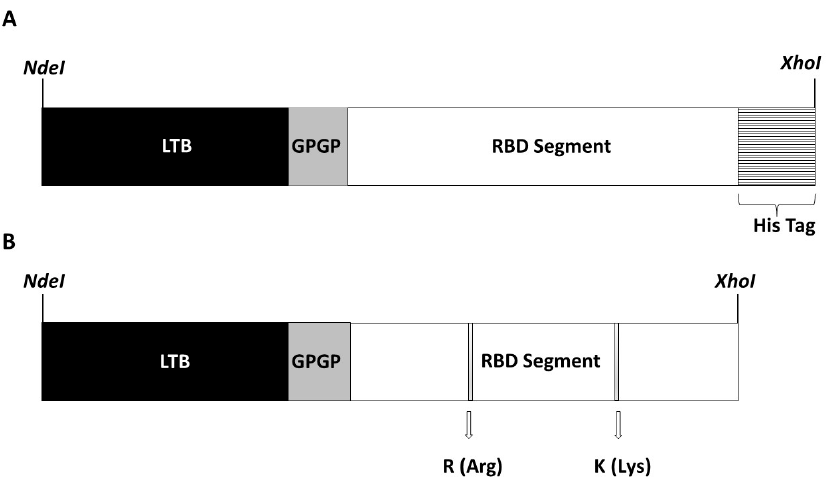
Figure 1. Schematic representation of the chimeric proteins produced and evaluated in this study. ( A ) Map of the chimeric protein LTB-RBD targeting the Wuhan isolate. ( B ) Map of the chimeric protein LTB-RBD targeting the delta variant. The fusion proteins comprise the full-length sequence of LTB (in black), a GPGP linker (in gray), a segment of the RBD from SARS-CoV-2 (aa 439 – 504, carrying B and T cell epitopes, in white), and hexa-histidine tag (in horizontal stripes). The delta variant construct has two amino acid changes (arrows): arginine (R) instead of leucine (L) and lysine (K) instead threonine (T). Nde I and Xho I restriction sites were placed at the 5 ′ and 3 ′ ends, respec- tively, to facilitate subcloning into the pET 21b (+) vector.